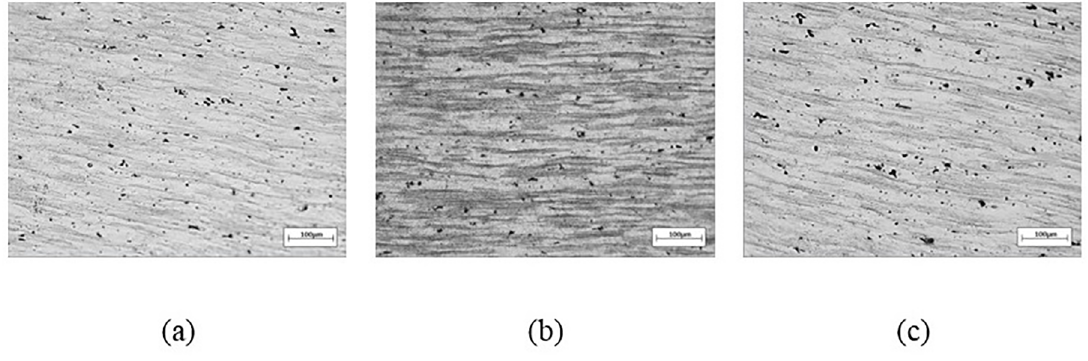
Figure 2. Microstructure analyzed by optical microscopy 100x magnification in TDxND plane, Keller 20s attack through: a) 1st pass at 180ºC b) 2nd pass at 130ºC, c) 2nd pass at 180ºC.